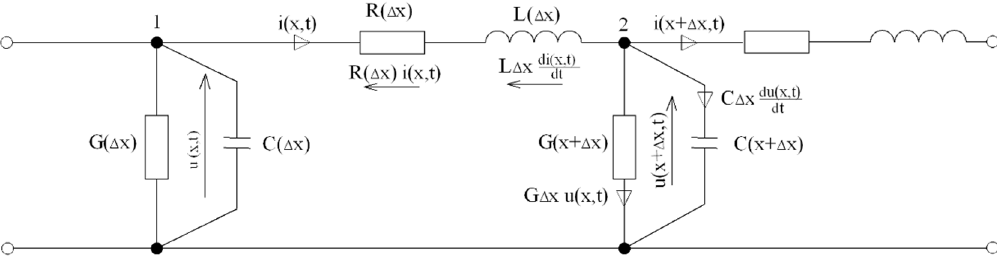
Figure 1. Application of Kirchhof’s law to a transmission line fragment. and transverse capacitance of the line into account, while line transverse capacitance is